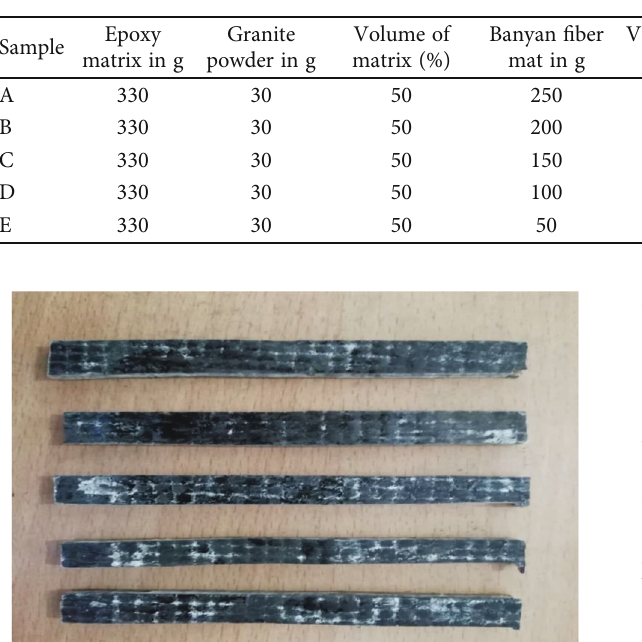
Figure 2: The fabrication process of composite laminates. Table 3: The weight fraction of ramie/banyan fi ber composite laminates.